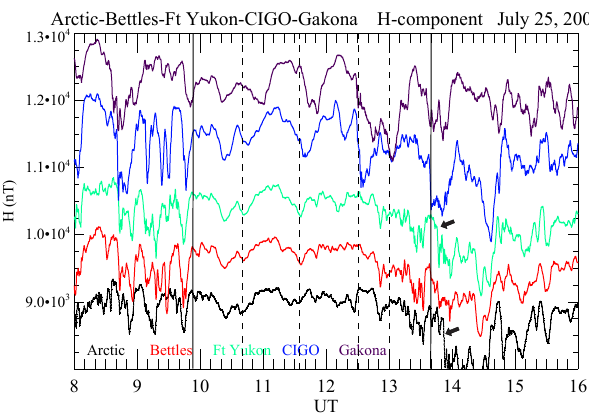
Figure 3. Alaska chain magnetograms during the interval 08:00– 16:00UT. Panels from top to bottom show H component magne- tograms at stations ordered by increasing magnetic latitude from top to bottom: Gakona (top; 63.6 ◦ MLAT), CIGO (65.4 ◦ MLAT), Ft. Yukon (67.4 ◦ MLAT), Bettles, and Arctic Village (bottom; 68.7 ◦ MLAT). Vertical guidelines at 10:00 and 13:30UT delimitate a period of moderate (attenuated) electrojet activity compared to the periods before and after. The stepwise poleward expansion of the auroral electrojet at 13:45 and 13:50UT is marked by the tilted bold arrows.